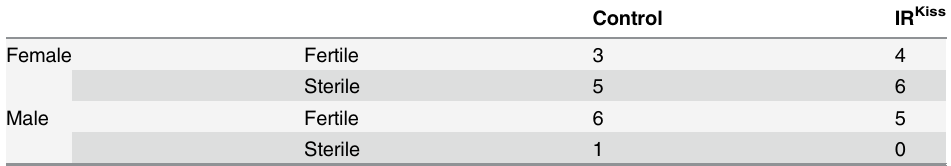
Table 4. Fertility after 4 months HFD treatment.